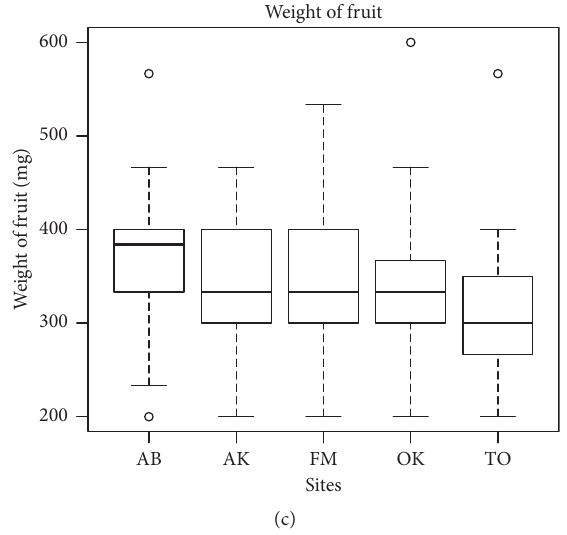
Figure 9: Distribution of trees’ fruit characteristics at the five sites. Table 11: Mean values of the parameters of the fruit according to the climatic zone. Climatic zone